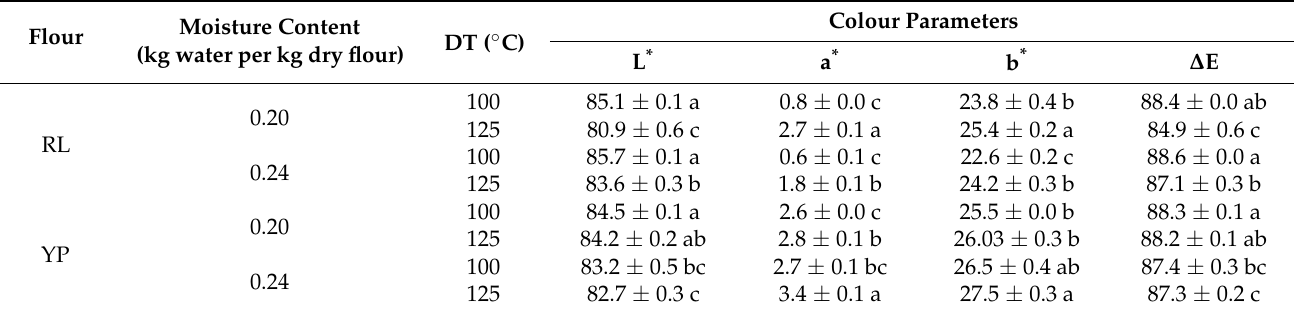
Table 3. Colour parameters (mean ± standard error) of third-generation red lentil (RL) and yellow pea (YP) products as affected by feed moisture content and die temperature (DT). For each flour type, results in each column are significantly different if designated with different lowercase letters ( p ≤